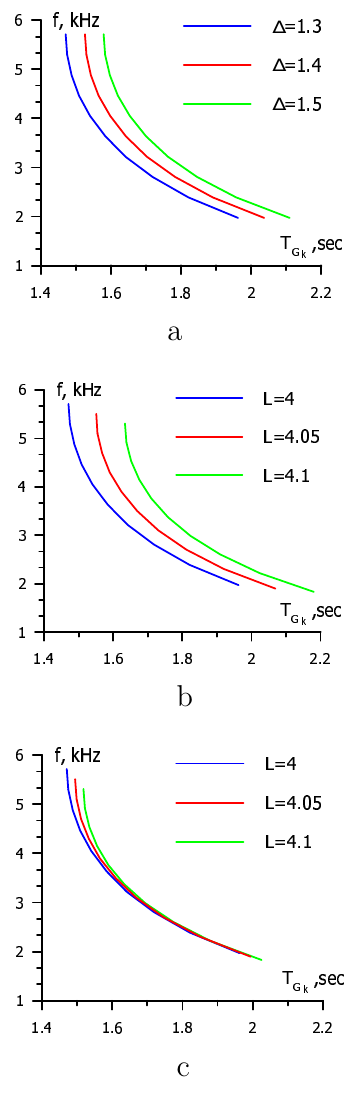
Fig. 6. The group delay time of the first eigenmode propagating from the eautor to the ionosphere in the different ducts: a − ducts with differenct density enhancements 1 = N dL /N ∞ L ( L =4, N ∞ L ≈ 450cm − 3 ) b − ducts at different magnetic shells L , plasma density is the same, ( 1 = 1 . 3 ,N ∞ L ≈ 450cm − 3 ) c − ducts at different magnetic shells L , plasma density N ∞ L ∝ L − 3 ,(1 = 1 . 3 ,N ∞ L ≈ 450cm − 3 at L =4). Duct radius at the equator a L ≈